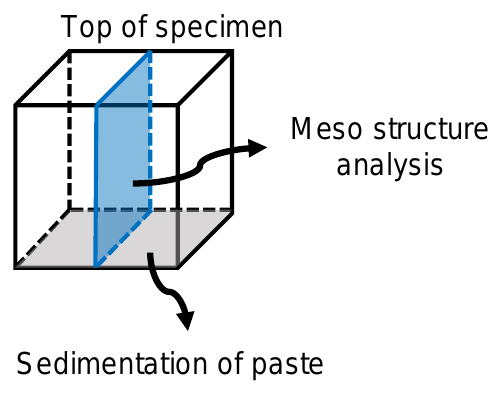
Figure 5. Shear procedure for the rheology test on the paste. The sedimentation of paste on the bottom of pervious concrete sized 100 mm × 100 mm × 100 mm was evaluated by calculating the percentage of area of paste on the bottom of pervious concrete after scanning and binarizing the images on the bottom of pervious concrete as shown in Figure 6.